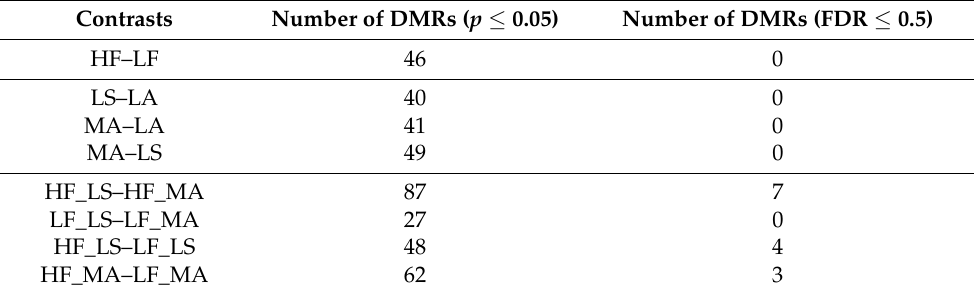
Table 3. Tested contrasts and numbers of DMRs obtained using two different thresholds.